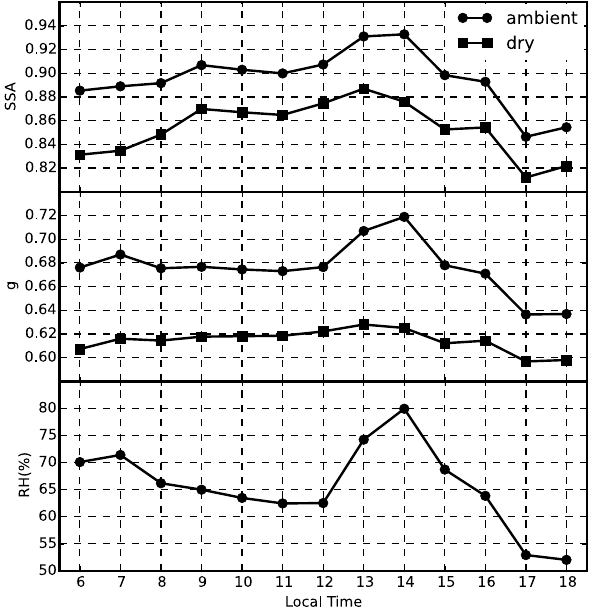
Figure 7. The diurnal variations of SSA, g and RH on Julian day